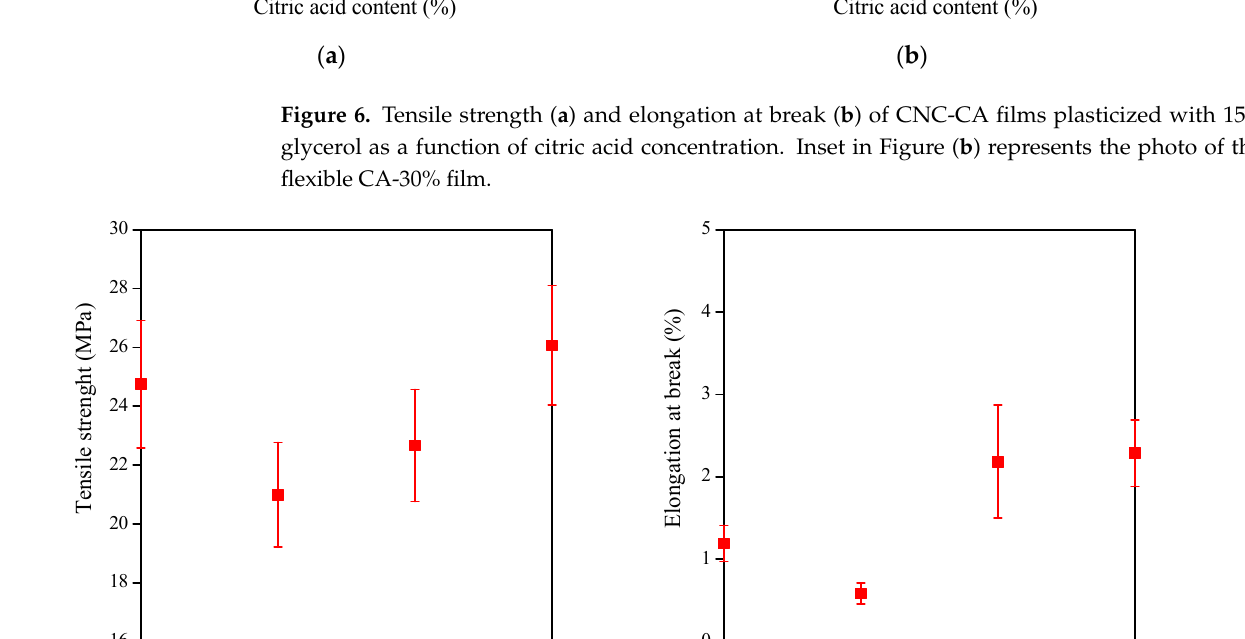
Figure 6. Tensile strength ( a ) and elongation at break ( b ) of CNC-CA fi lms plasticized with 15% glycerol as a function of citric acid concentration. Inset in Figure b represents the photo of the fl exible CA-30% fi lm.